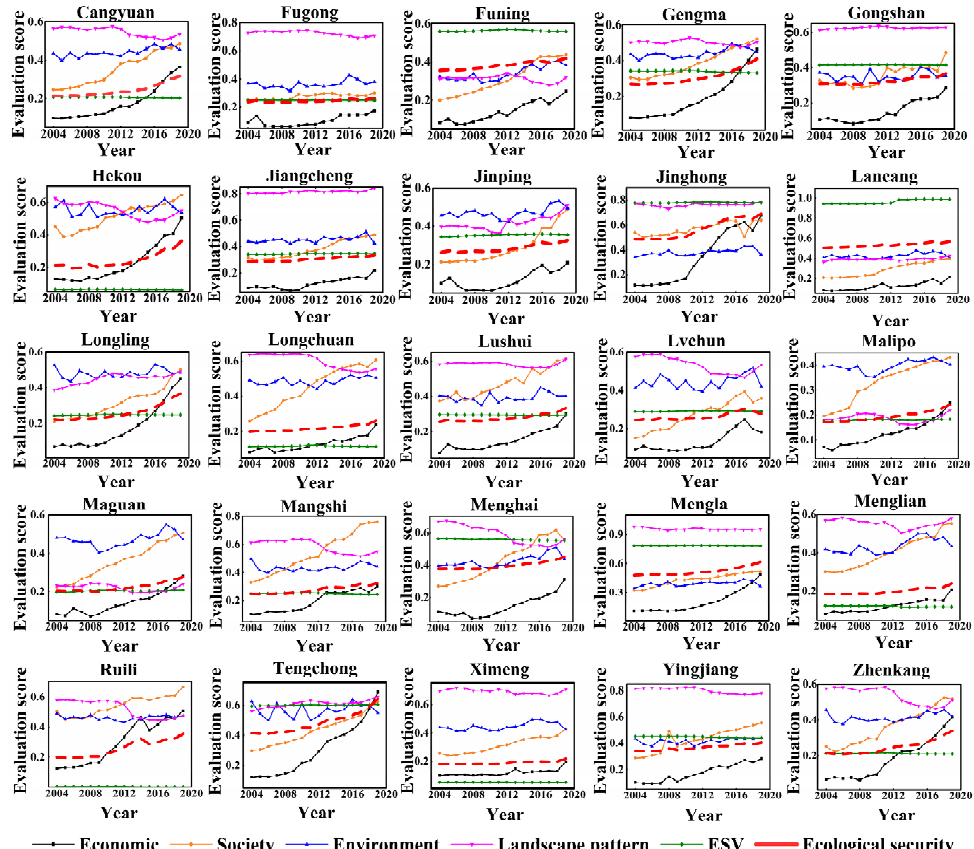
Figure 3. Evaluation scores for temporal changes in ecological security and subsystems (economic, social, environmental, landscape pattern, and ecosystem service value (ESV)) in 25 border counties of Yunnan Province, China.